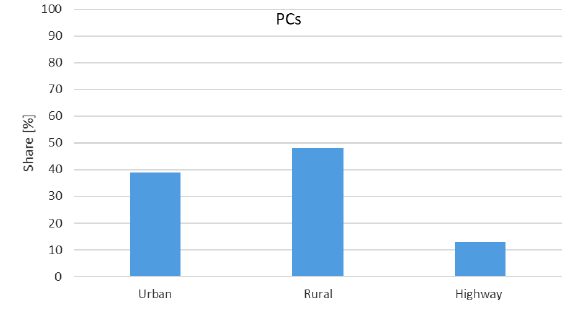
Fig. 1. Mileage share per road class Table 2. Average monthly temperatures in Poland in 2019